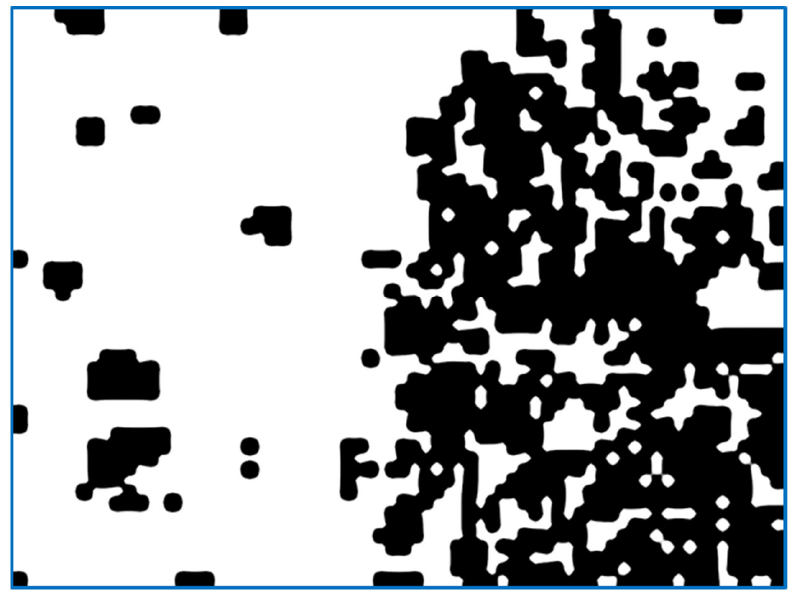
Figure 4. The feature selection result is based on the fragment average brightness or arithmetic mean of the brightness, 64 × 64 in size, with a step of 32 pixels.